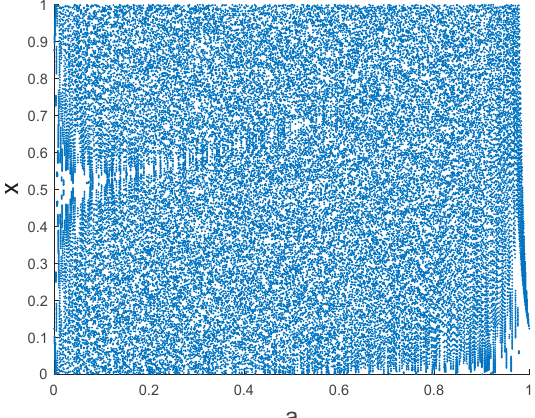
Figure 1. Bifurcation diagram of Kent chaos.